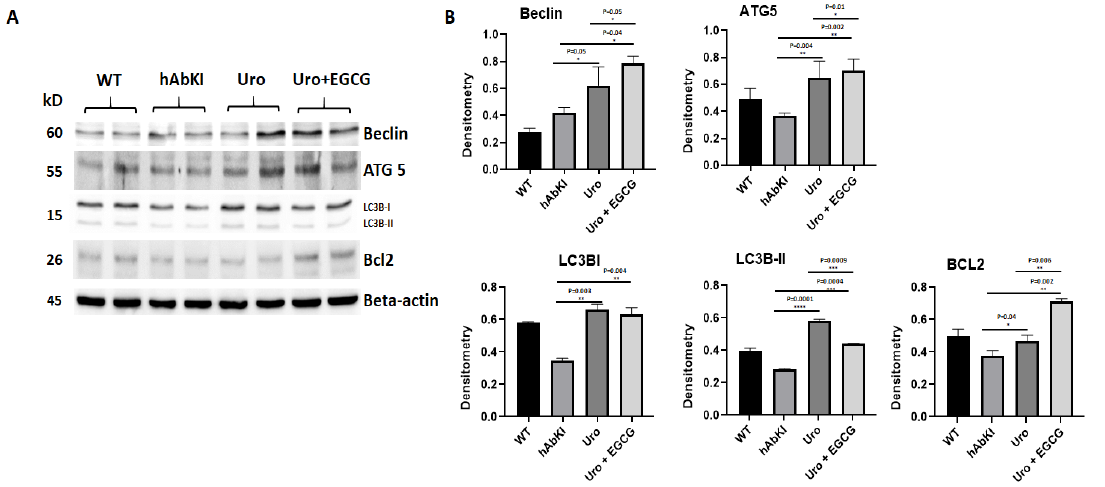
Figure 6. Immunoblotting analysis of autophagy proteins in lysates obtained from brains of seven- month-old hAbKI and treated hAbKI mice with Urolithin A and EGCG. ( A ) Representative autophagy immunoblots for hAbKI mice and treated hAbKI mice with Urolithin A and EGCG. ( B ) Quantitative- densitometry analysis for autophagy proteins ATG5, Beclin, BCL2, LC3B-I and LC3B-II showed they were significantly increased in the treated hAbKI mice with Urolithin A and EGCG as compared to hAbKI